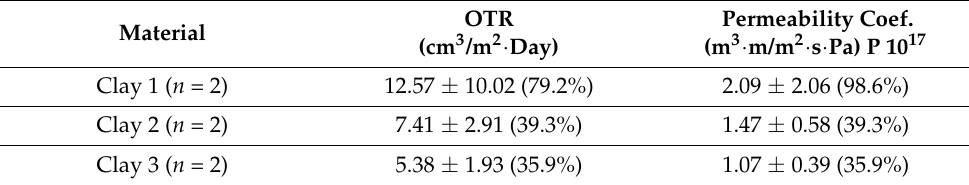
Table 6. Main permeation results of tested claystone samples in liquid contact